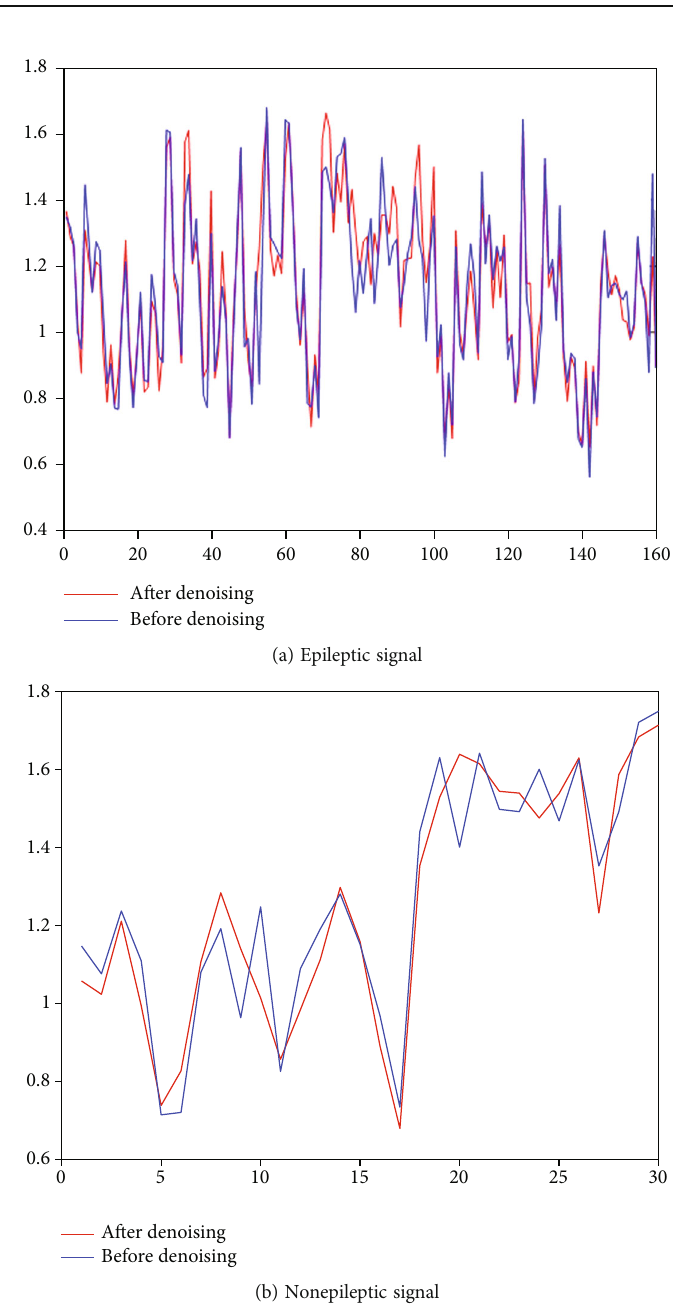
Figure 7: Trend of mean PSD.